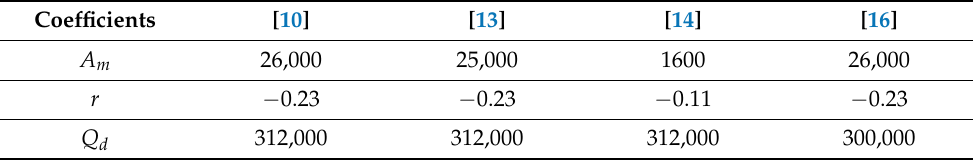
Table 3. Parameters used in the grain size equation for meta-dynamic recrystallization of carbon– manganese steel [10,14,16], and low carbon steel